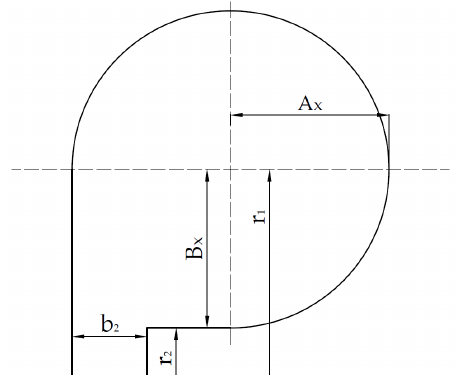
Figure 8. Inlet volute area geometry.